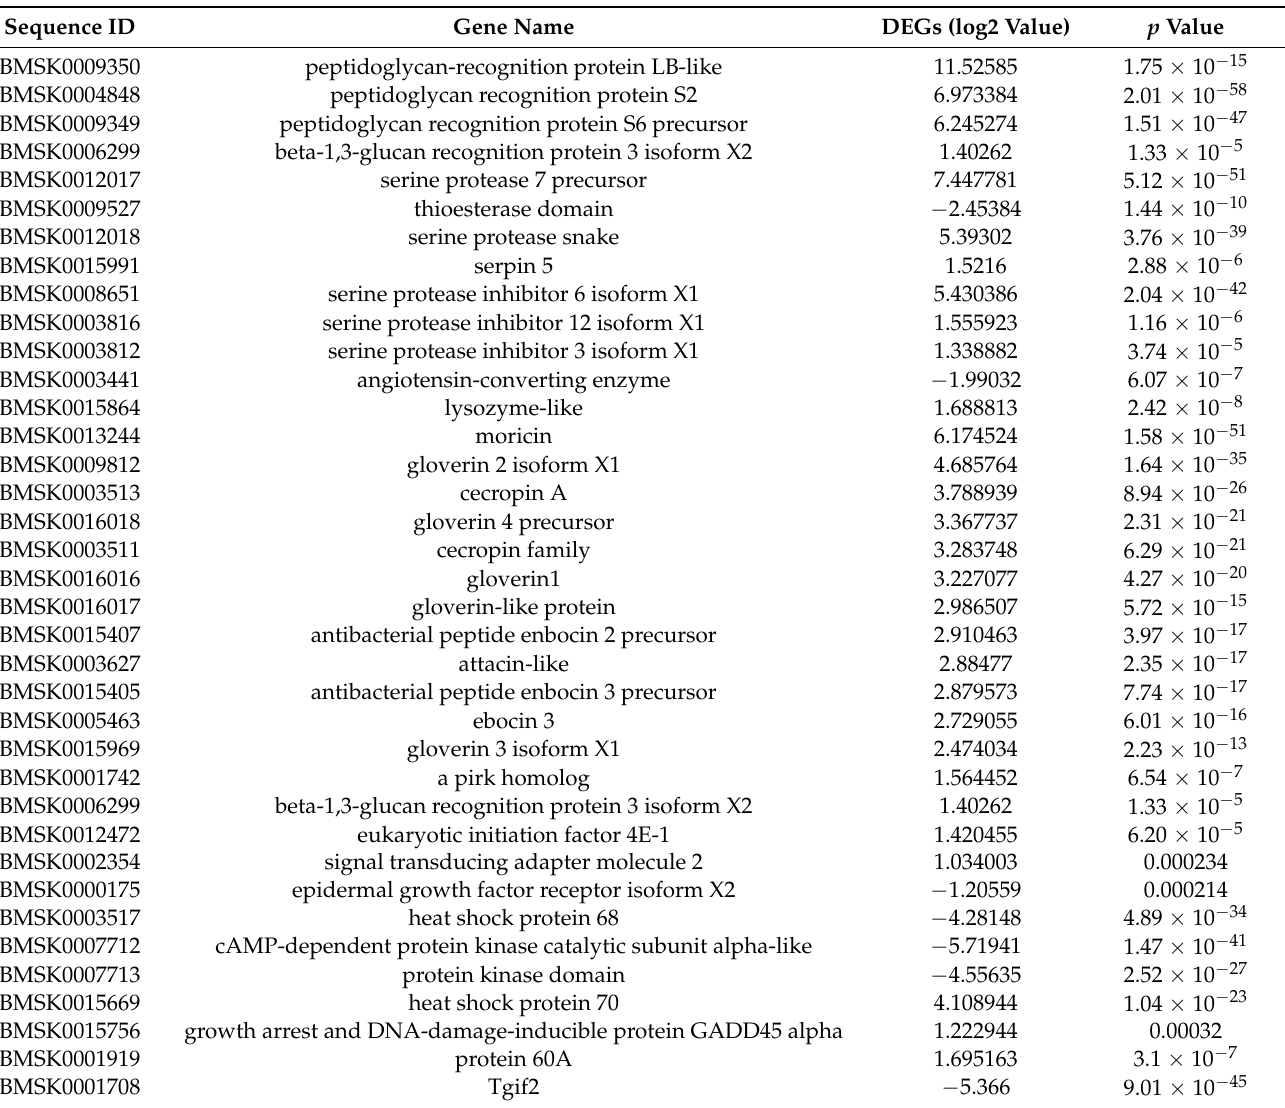
Table 5. Humoral-immune-response-related